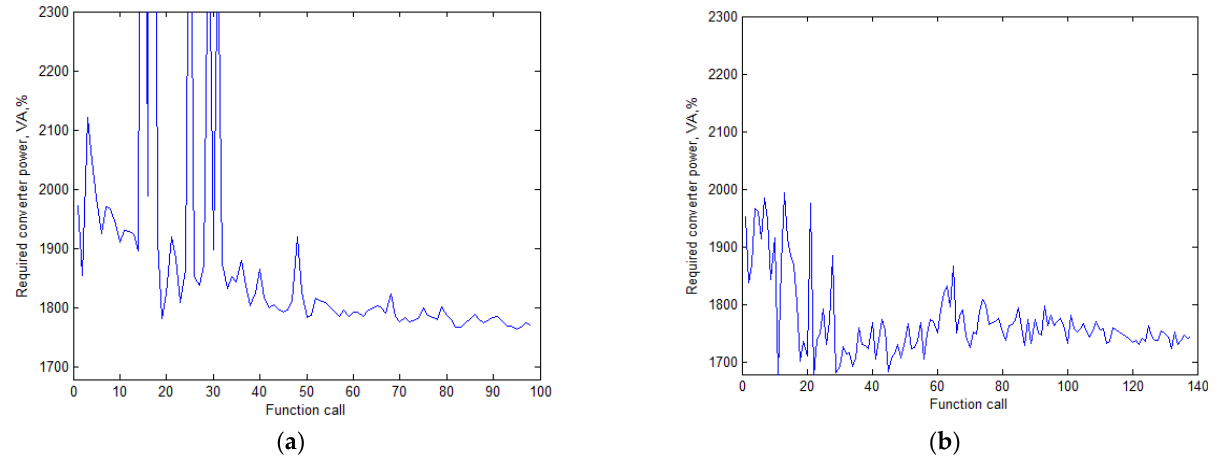
Figure 7. The change in the required converter power during optimization. ( a ) PMFSG; ( b ) IPMSG.